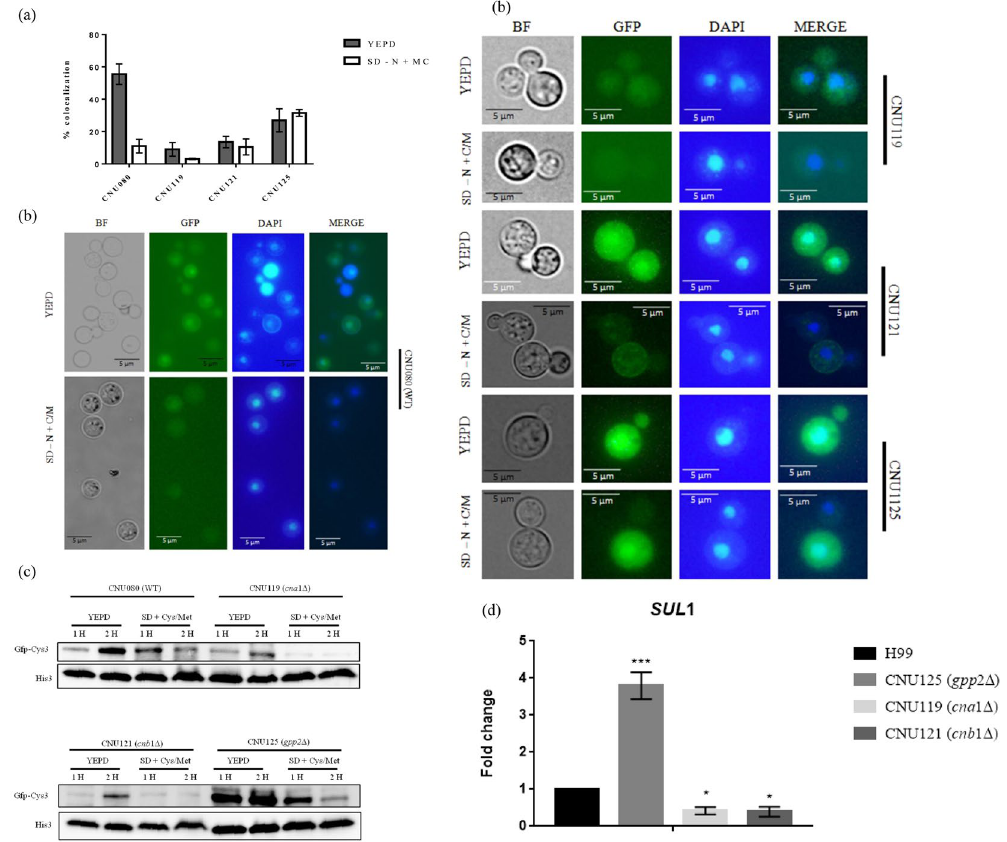
Figure 7. GFP-Cys3 cellular localization and expression pattern in western blotting in mutant background. ( a ) Bars represent percentage of GFP and DAPI localization accessed by fluorescence microscopy in CNU080 (wild type), cna1 Δ (CNU119), cnb1 Δ (CNU121), and gpp2 Δ (CNU125) cultivated for 2 h in YEPD and SD-N + Cys/Met; ( b ) fluorescence microscopy images showing localization of DAPI and GFP in YEPD (left) and SD-N + Cys/Met (right side). Merge is the overlay of DAPI and GFP images and localization is represented by the yellowish color; ( c ) western blotting of total proteins extracted from strain CNU080, CNU119, CNU121, and CNU125 cultivated for 1 and 2 hours in YEPD and SD-N + Cys/Met. Mouse Anti-GFP primary antibody was used at 1:2000 dilution and secondary anti-mouse horseradish peroxidase-linked antibody was applied at 1:2000 dilution. Loading control was done with histone H3 protein with rabbit anti-His3 antibody (1:2000) as primary and anti-rabbit secondary antibody horseradish peroxidase linked (1:2000). The original western blot images are shown in Supplementary data; ( d ) expression pattern by qPCR of C . neoformans sulfate permease ( SUL1 ) in wild type (H99), gpp2 Δ (CNU125), cna1 Δ (CNU119), and cnb1 Δ (CNU121) in YEPD. Asterisks denote the statistically significant differences encountered between wild type H99 and the mutants. * p < 0.05, *** p <